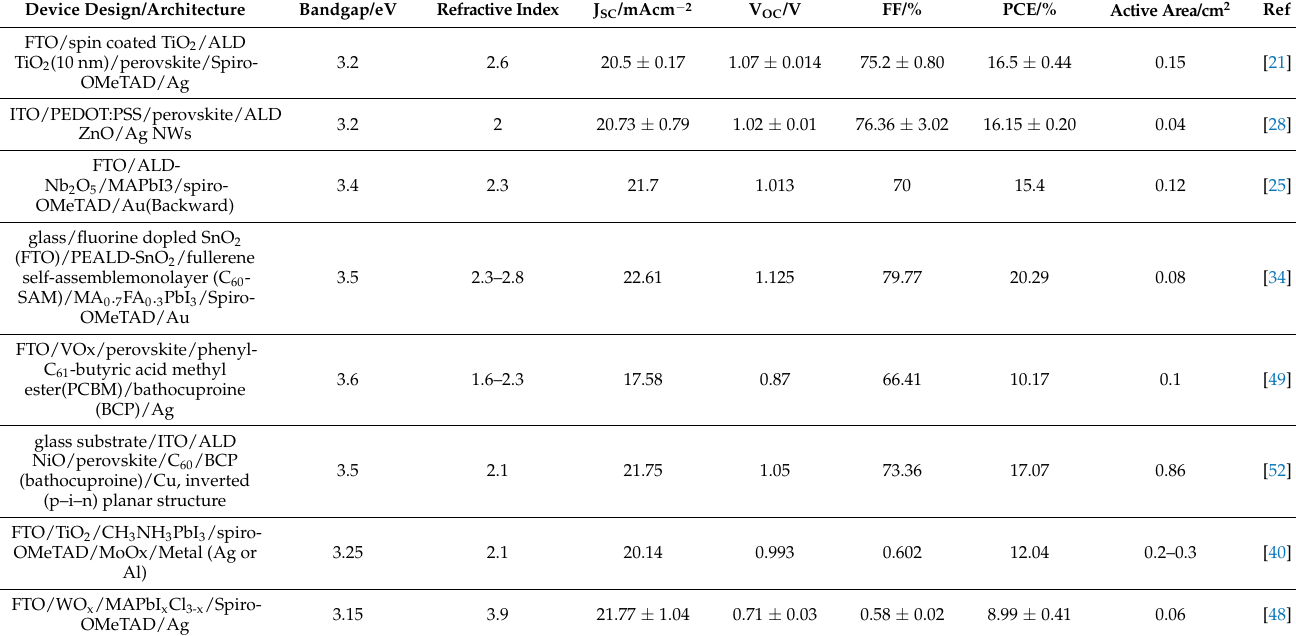
Table 1. The summary of charge-transporting layers (CTL) and their